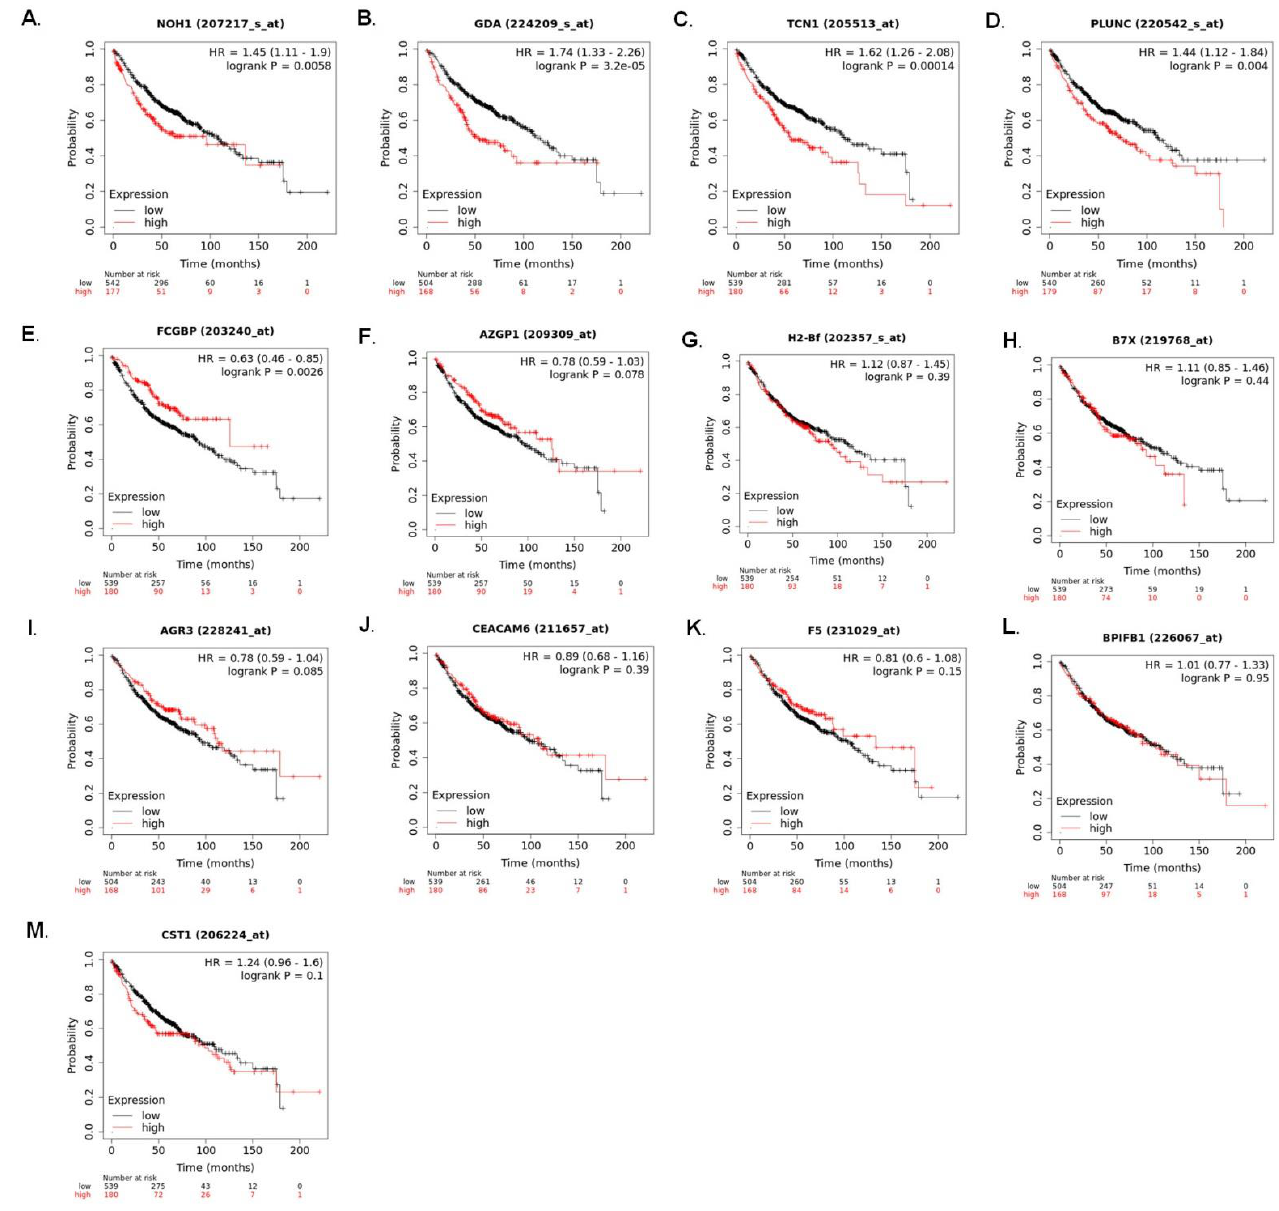
Figure 3. FCGBP , CST1 , F5 , CFB , and BPIFB1 correlated to lung adenocarcinoma patient’s clinical prognosis. Kaplan – Meier survival curves of the mRNA expression levels of candidate genes: